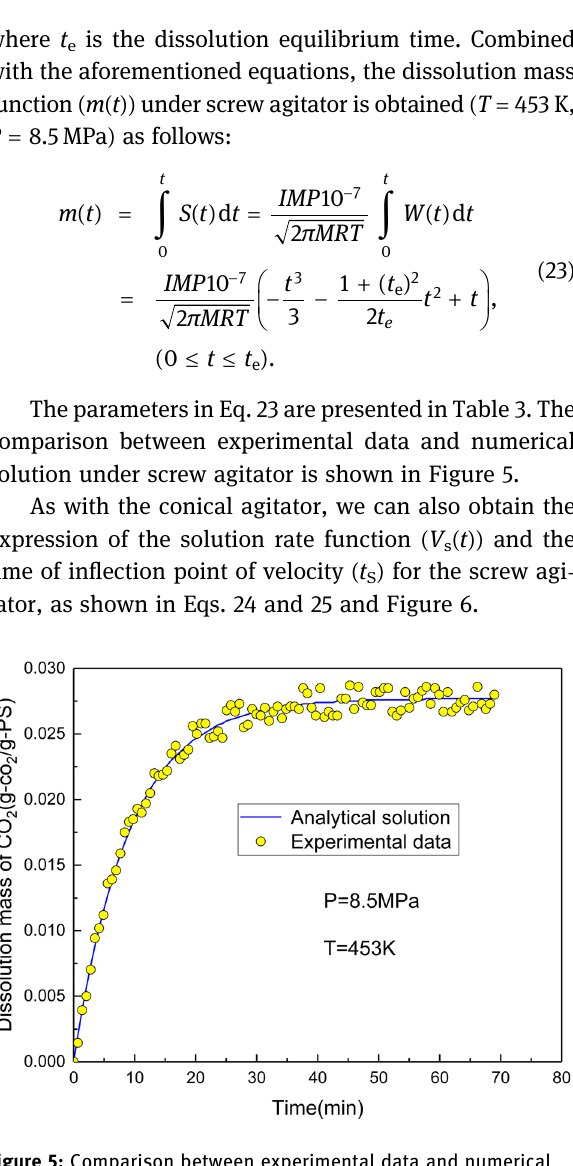
Figure 5: Comparison between experimental data and numerical solution under screw